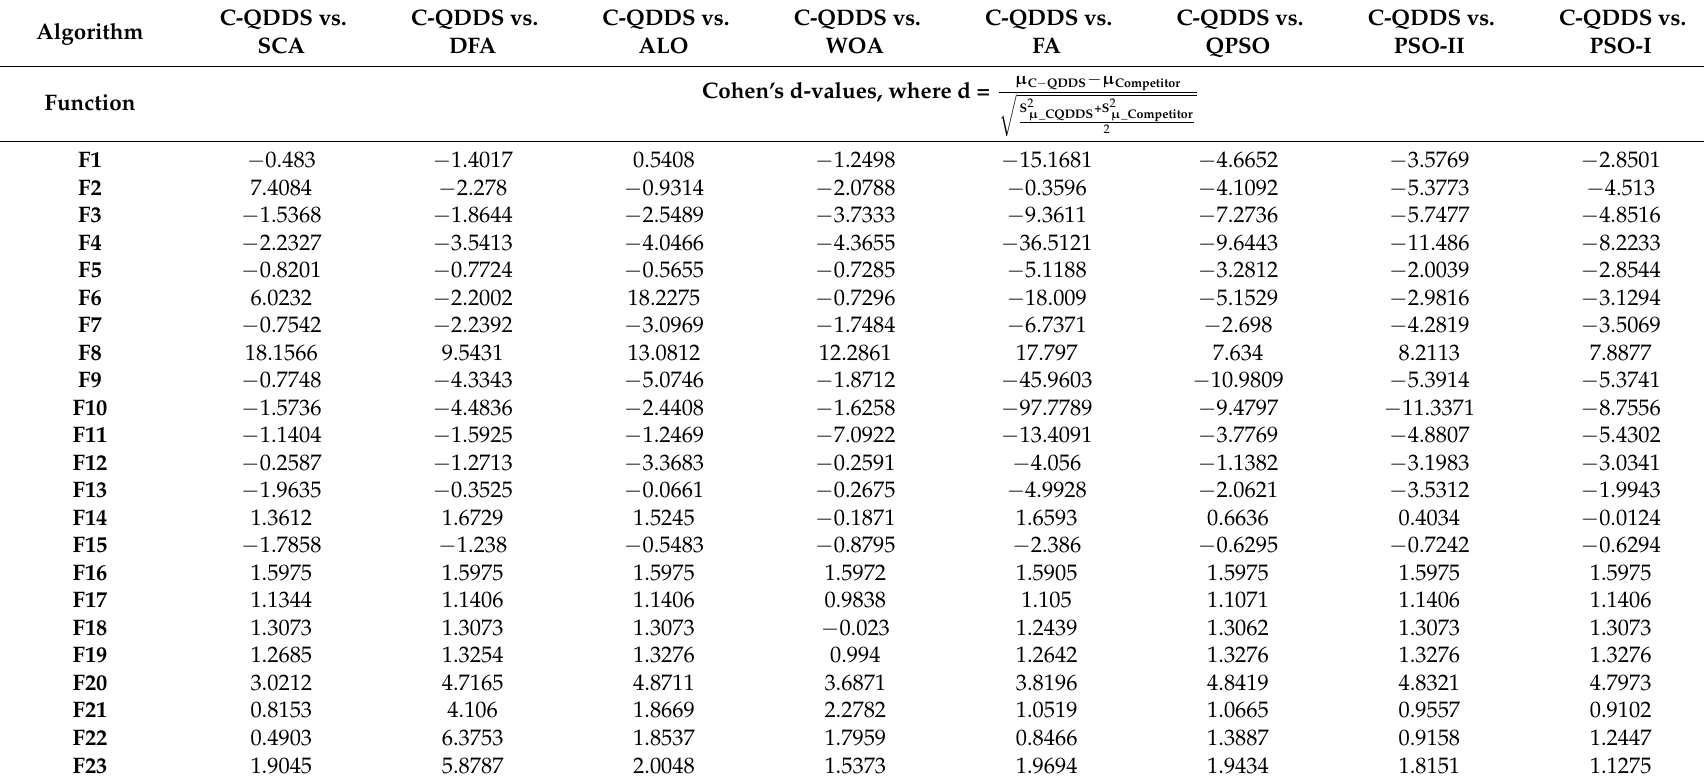
Table 16. Cohen’s d-values for C-QDDS v/s